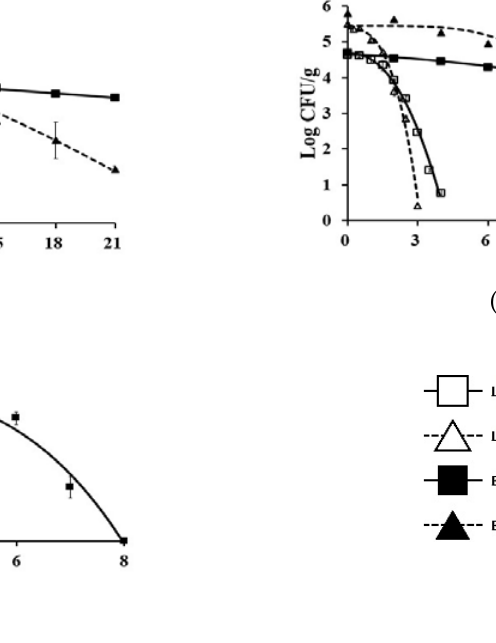
Figure 2. Primary survival models of Listeria monocytogenes (LM) and EHEC in yogurt as a function of temperature. LM in drinking yogurt: □, LM in regular yogurt: , EHEC in drinking yogurt: ■ , EHEC in regular yogurt: ▲ .